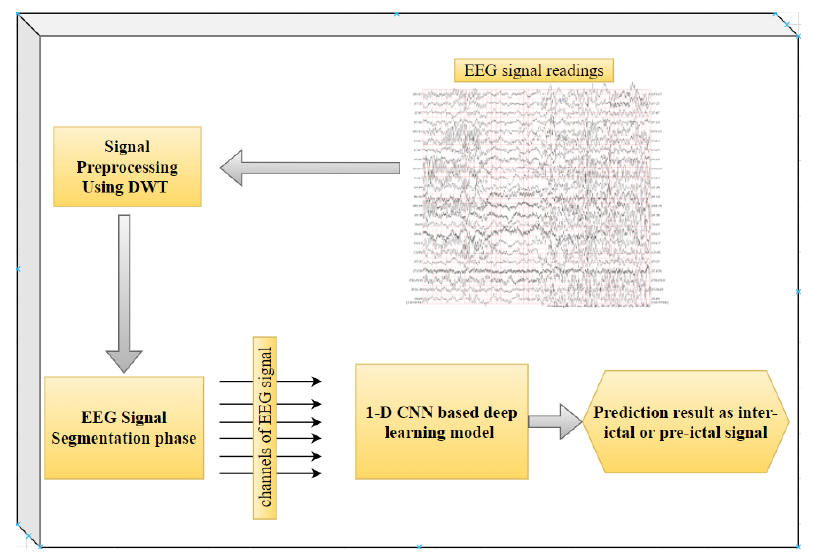
Figure 2. Proposed model architecture , consisting of a pre-processing module followed by an EEG signal segmentation phase and a deep learning